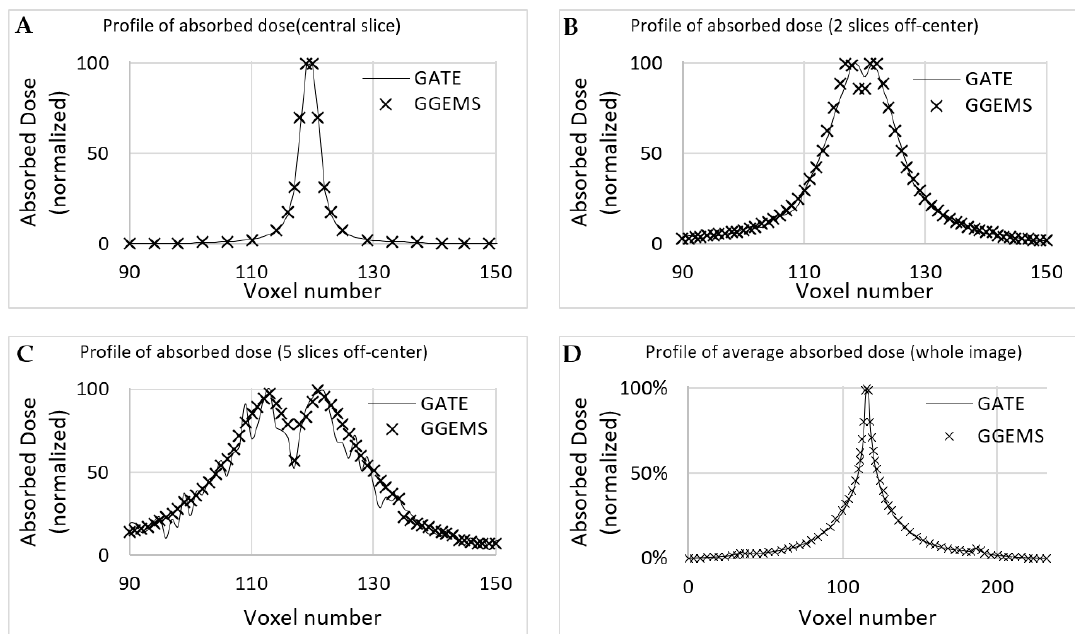
Figure 6. Profile of absorbed dose of the simulation of Amersham Health 6711 inserted in the CT phantom. Transverse orientation is used (as seen in Figure 7). ( A ) is the profile plot at the centre of the seed, ( B ) is the profile plot at the edge of the source, and ( C ) is a profile plot away from the seed. In ( D ), the profile plot when all slices were summed into one is depicted for the whole developed phantom. Cancers 2021 , 13 , 5315